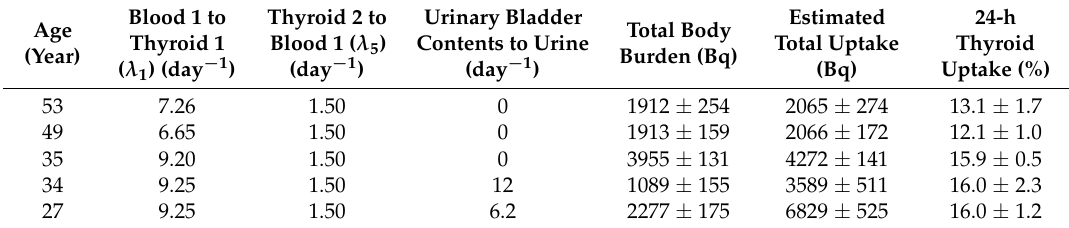
Table 3. Measurement of total body burden values; estimated total uptake, and 24-h thyroid uptake of 131 I, estimated from biokinetic calibrations with adopted variable parameters. The total body burden was at 11:30 on 16 March